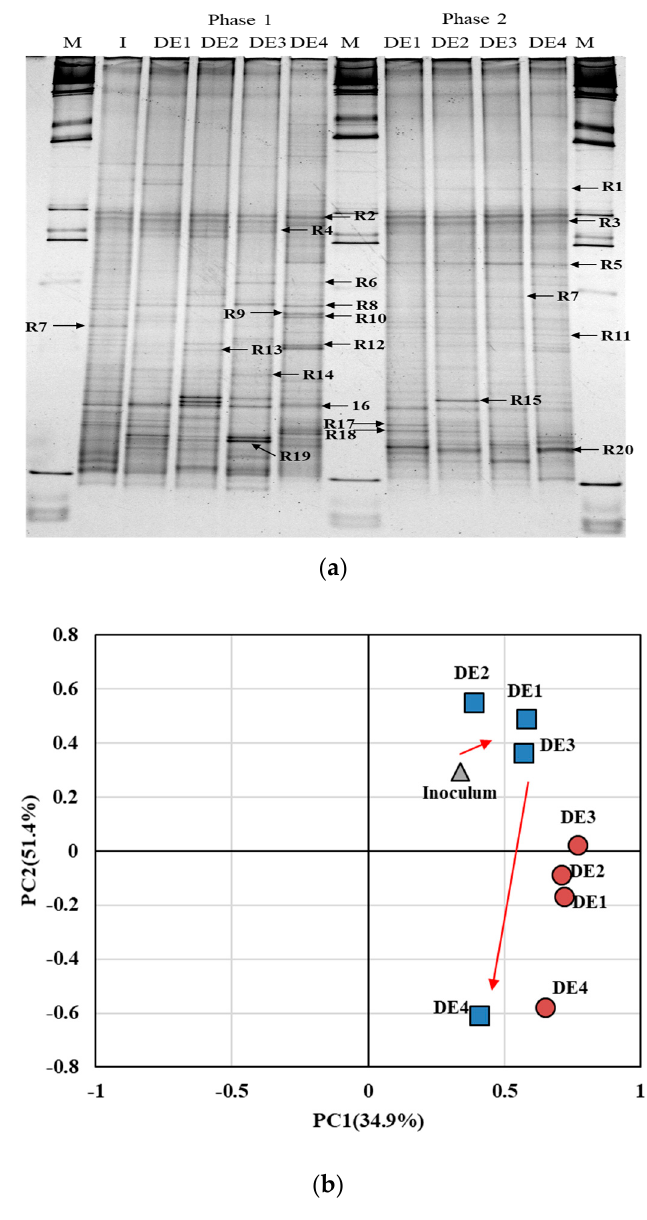
Figure 6. DGGE profiles ( a ) and PCA based on DGGE profiles ( b ) of EBR using domestic WW at phases 1 (square) and 2 (circle); The red arrow indicates the shift direction of the microbial community. Bands R2, R3 and R7 were unlikely to be involved in electricity generation because they were detected in all EBRs in each phase and band R7 was only found in the inoculum. However, as bands R1, R5, R15, and R20 were detected in phase 2 or the band intensity was relatively increased, they seemed to be related to electricity generation. In particular, band R20 was similar to Desulforhabdus sp., which may play a role in electricity production from sulfide oxidation [22]. However, band R1 was similar to Chitinophaga may be related to the anaerobic environment [23] (Table